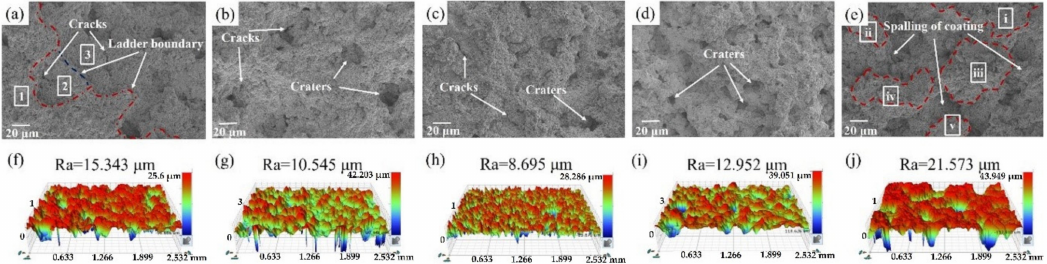
Figure 11. SEM and 3D morphology of eroded surfaces of ( a , f ) as-sprayed; ( b , g ) HT 650; ( c , h ) HT 800;